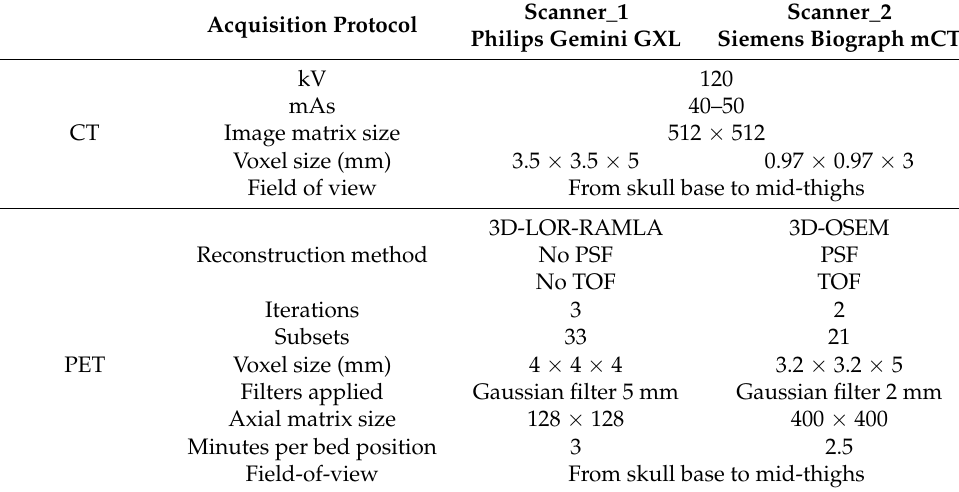
Table 1. Acquisition settings of the two employed